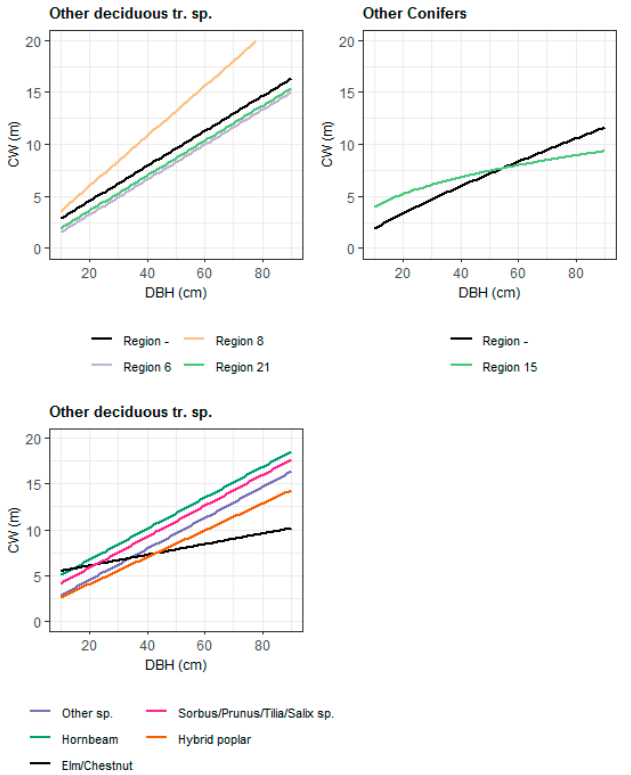
Figure 3. Effects of DBH (cm) on the CW (m) of the remaining broadleaf and coniferous species, for which the number of observations was too small to calibrate CW models for each species. The differences between tree species and growth regions were incorporated by dummy variables.